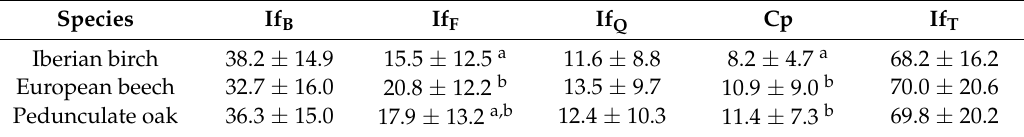
Table 3. Summary of the neighbourhood characteristics for the three species.